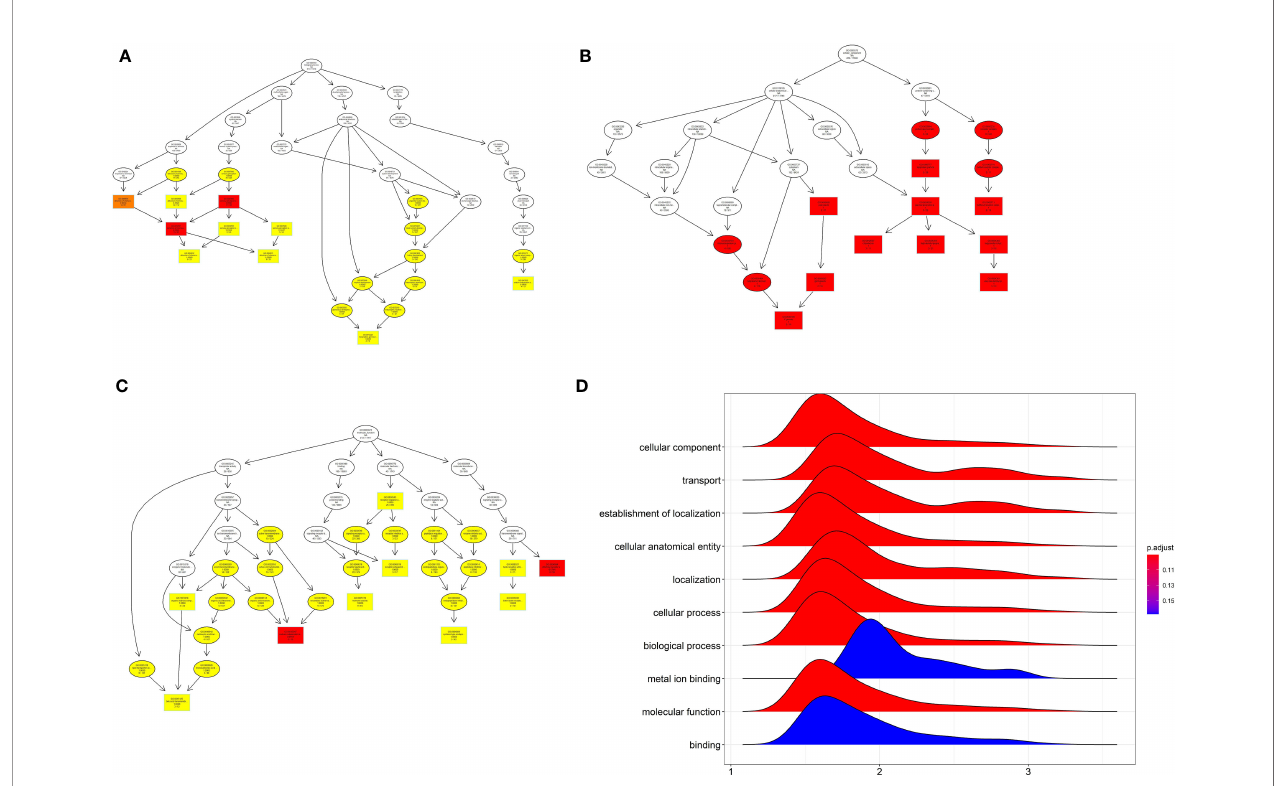
FIGURE 2 | GO enrichment analysis and GSEA of differentially expressed mRNA. (A) The GO_BP enrichment analysis of differentially expressed mRNA. (B) The GO_MF enrichment analysis of differentially expressed mRNA. (C) The GO-CC enrichment analysis of differentially expressed mRNA. (D) GSEA analysis of differentially expressed mRNA.